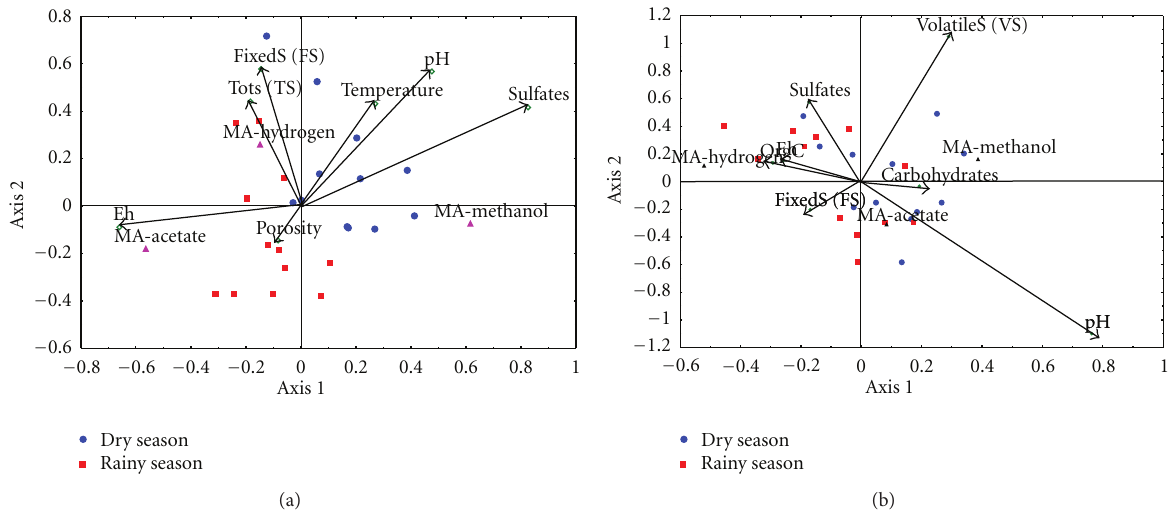
F 4: Relationship between environmental variables and methanogenic community in Chantuto-Panzacola (a) and Carretas-Pereyra (b).